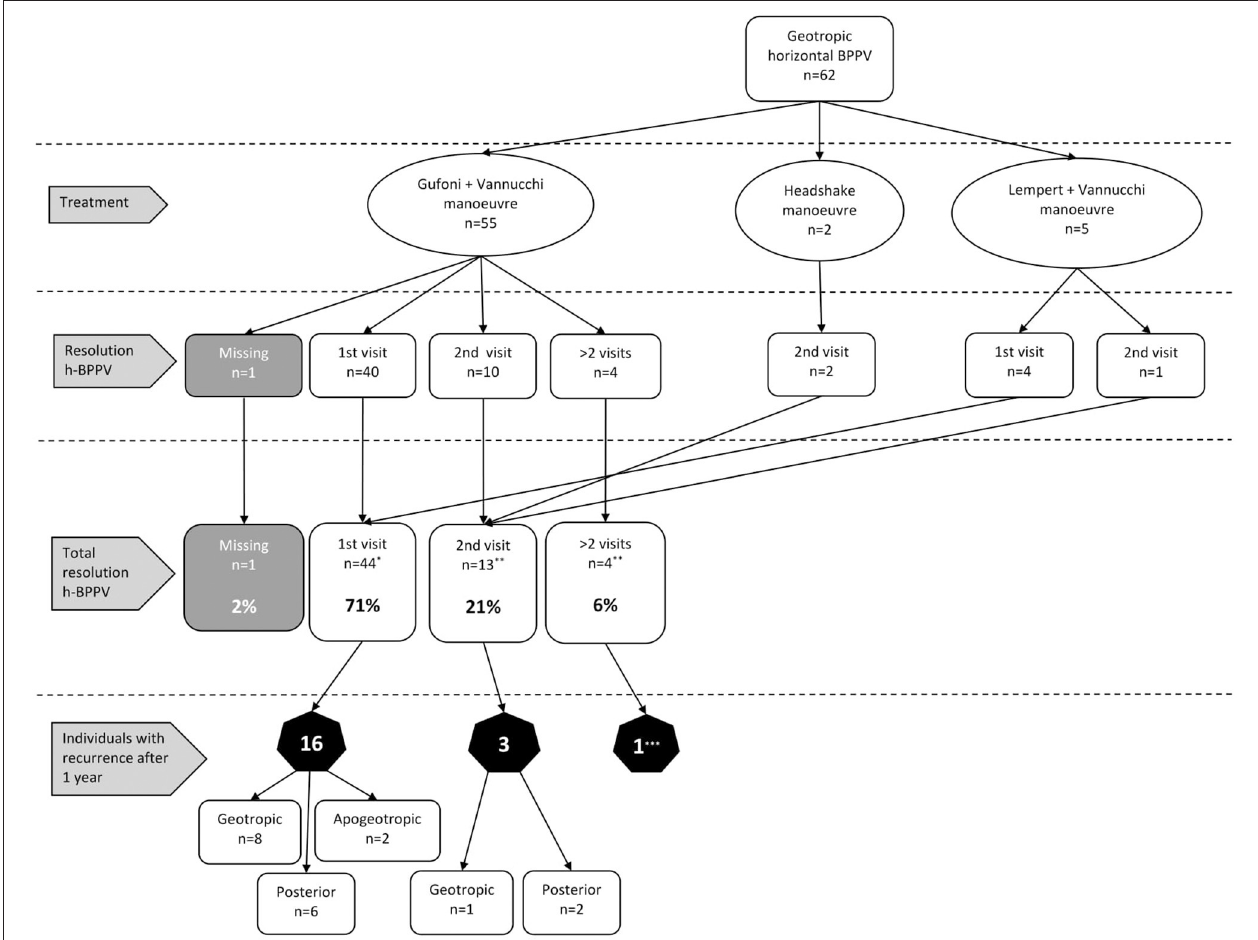
FIGURE 1 | Results of our treatment protocol and the number of recurrences for geotropic h-BPPV. (*) 14 patients received additional treatment for posterior canal BPPV. (**) 3 patients received additional treatment for posterior canal BPPV. (***) 1 patient with a suspected recurrence when contacted by telephone. The type of recurrence was not documented since this patient decided to continue treatment